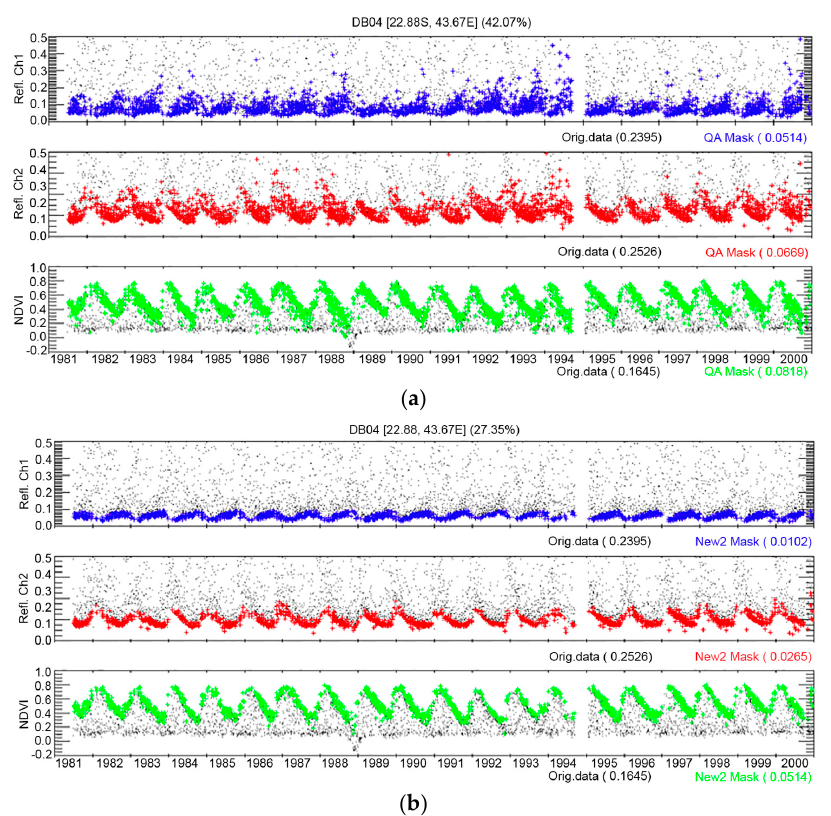
Figure 5. AVHRR time-series of channel 1 (blue) and channel 2 (red) surface reflectance and the NDVI (green) using ( a ) CLAVR or ( b ) LCDR cloud masks for a deciduous broadleaf site in Madagascar. Black symbols are clouds. The standard deviation of the unfiltered data of the time series (original data) and of the cloud filtered time series (QA mask for CLAVR, New2 mask for the LCDR cloud mask) are also provided for each of the bands and the NDVI. The percentage of clear data is also provided for each cloud mask at the top of the figure.